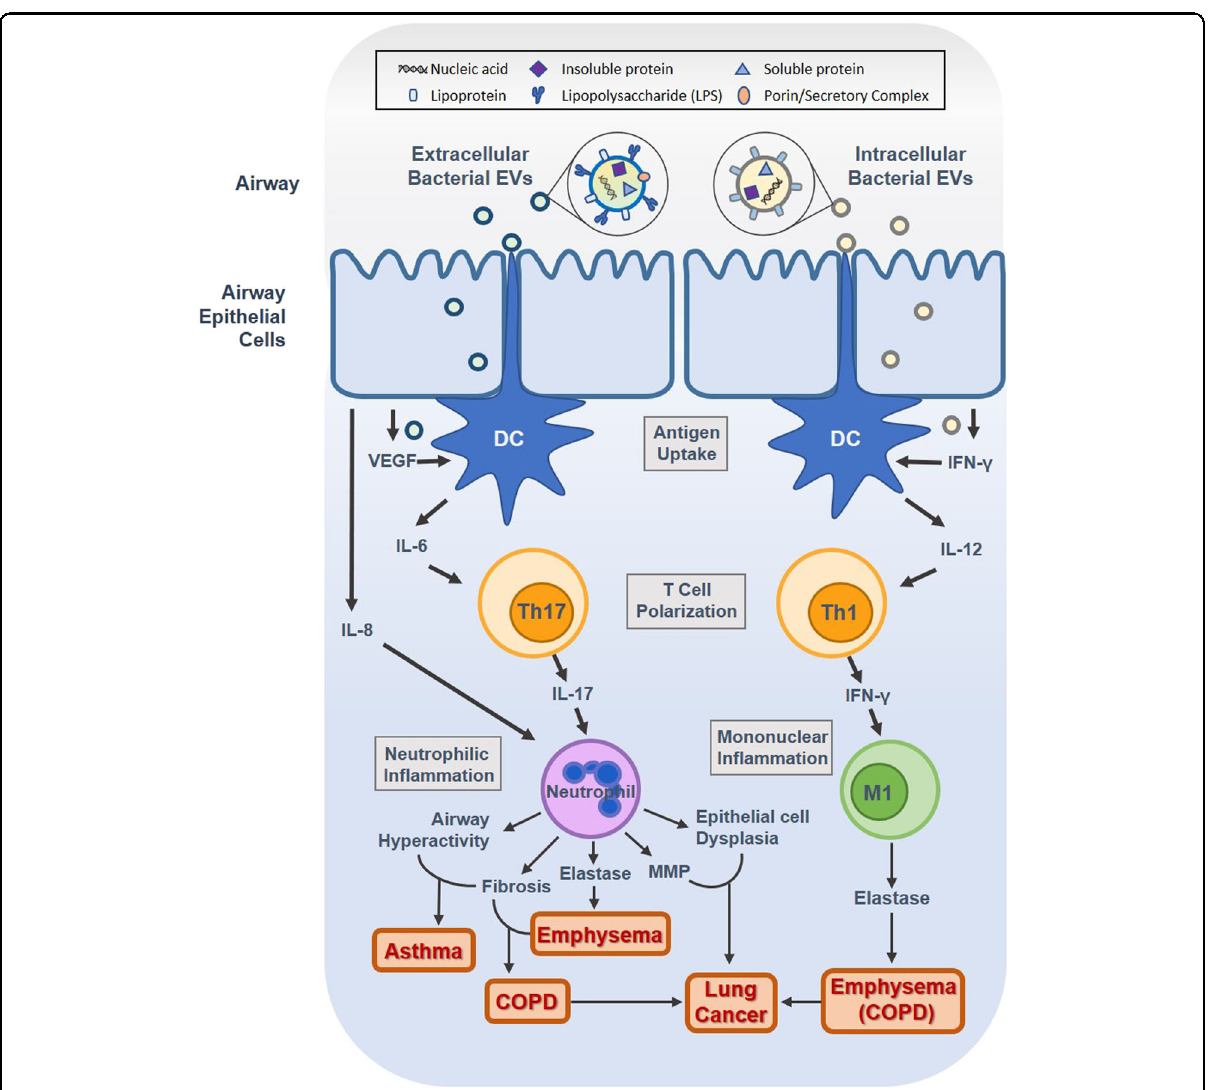
Fig. 3 Bacteria-derived extracellular vesicles (EVs), especially Gram-negative outer membrane vesicles (OMVs), induce Th17 immune response and lead to neutrophilic in fl ammation. Intracellular bacteria-derived EVs, such as Gram-positive mycobacterial membrane vesicles (MVs) induce Th1 response and lead to mononuclear in fl ammation. These immune responses contribute to the development of asthma, emphysema, COPD, and lung